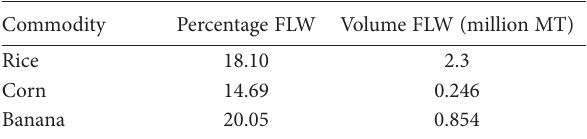
Table 3. Total estimated FLW in the Philippine FSC by